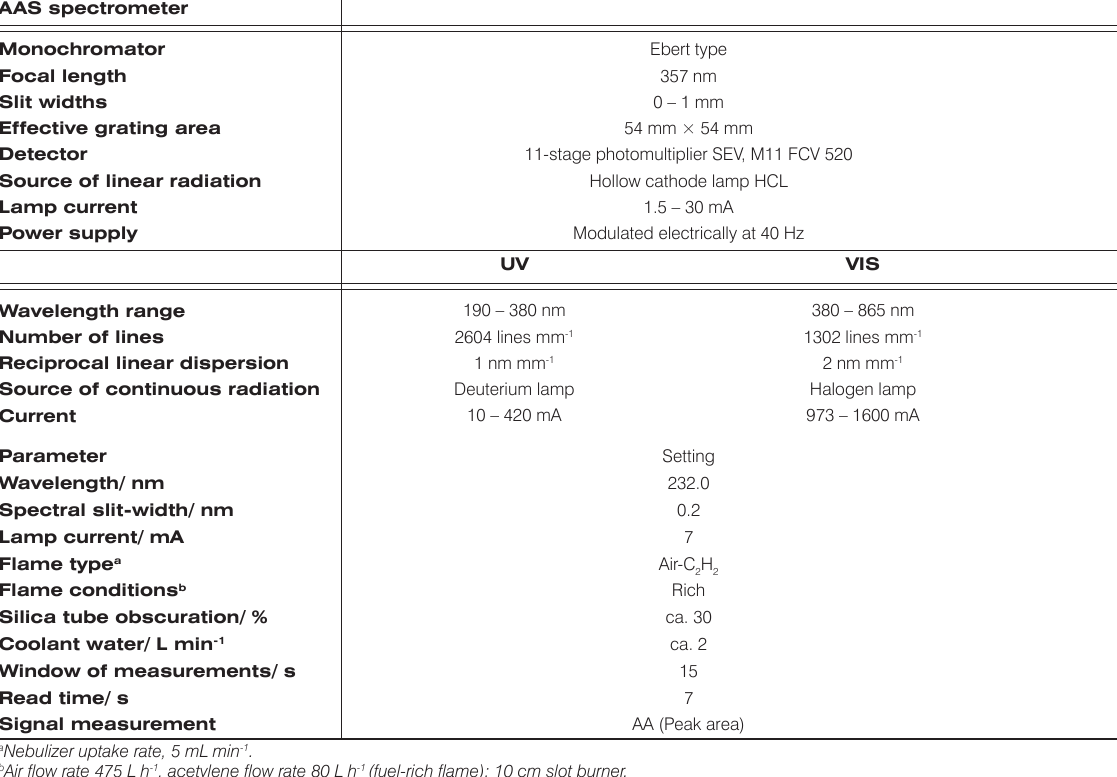
Table 1. Apparatus and operating parameters for determination of nickel by